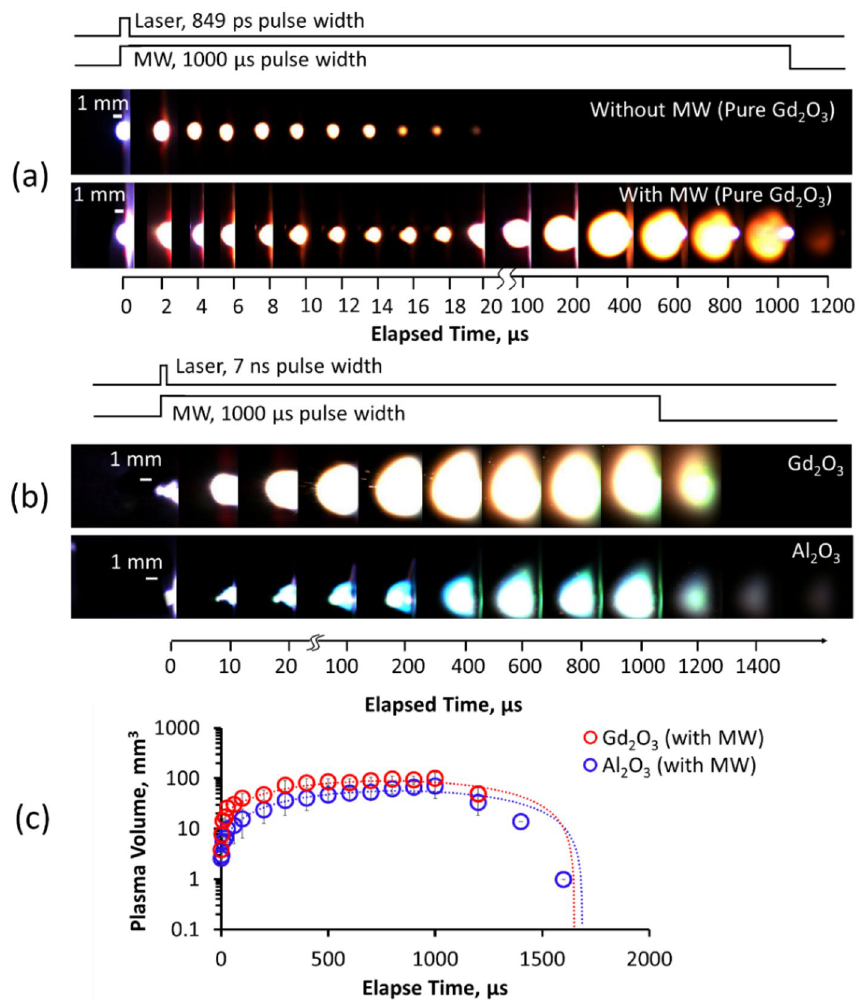
Figure 3. Visualized plasma formation of ( a ) pure Gd 2 O 3 using MWE-FC-MLIBS and the standard micro- laser. The well-studied ( b ) plasma formation and the ( c ) corresponding plasma volume approximations on Al 2 O 3 using microwave-enhanced nano-second ablation was also compared with pure Gd 2 O 3